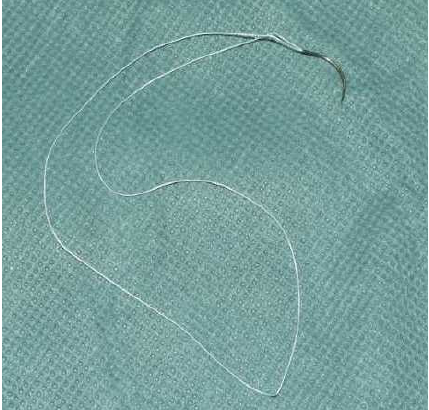
Figure 1. FiberLoop ® suture material 4.0.